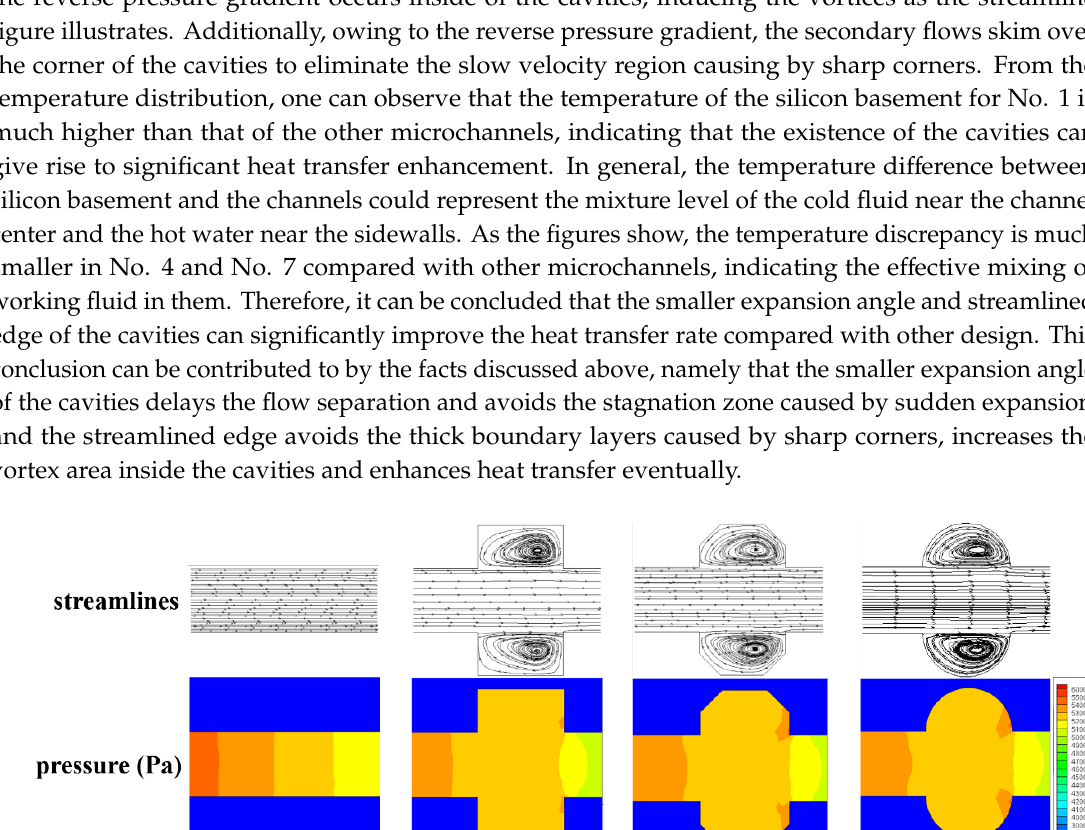
Figure 10. Local streamlines, pressure and temperature distribution of Group 2 and straight microchannel (No. microchannel (No. 1).